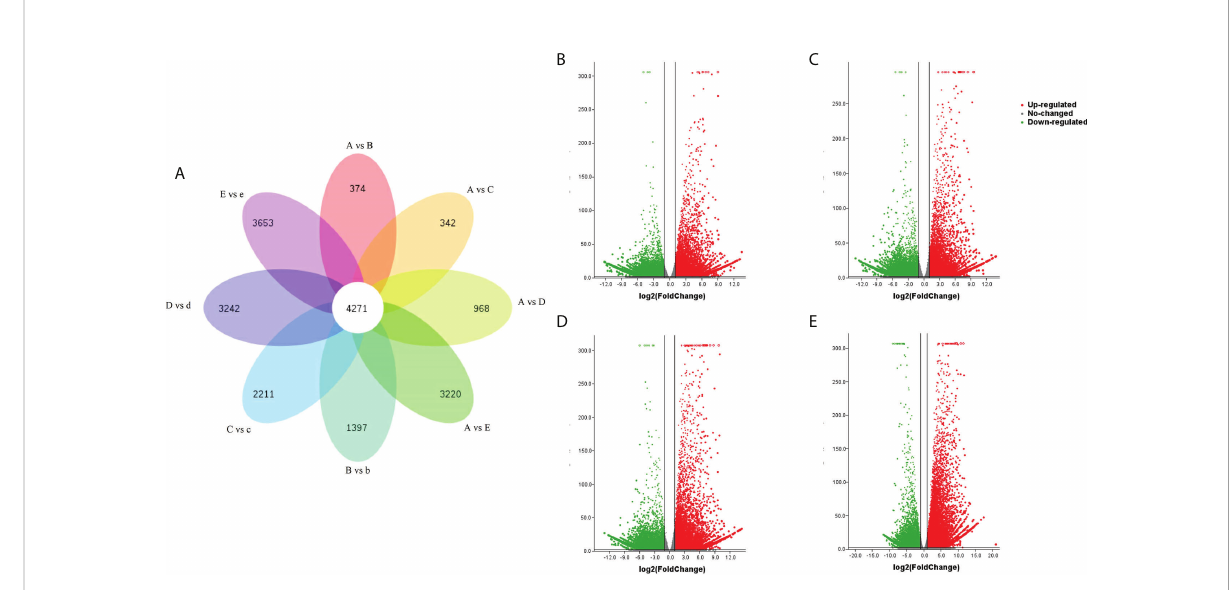
FIGURE 2 Transcriptomic analysis of the DEG distribution in the nine seed samples. (A) Venn diagram representation of the stage-speci fi c DEGs distribution in the seed samples. A vs B, A vs C, A vs D, A vs E, B vs b, C vs c, D vs d and E vs e represent the DEGs in each pairwise comparison, respectively. (B – E) Differentially expressed gene volcano map of cold treatment for 14 d, 28 d, 42 d or germination. (B – E) were represent A vs B, A vs C, A vs D, and A vs E, respectively. Differentially expressed genes were: expression difference foldlog2FoldChange> 1 and signi fi cance p- value <